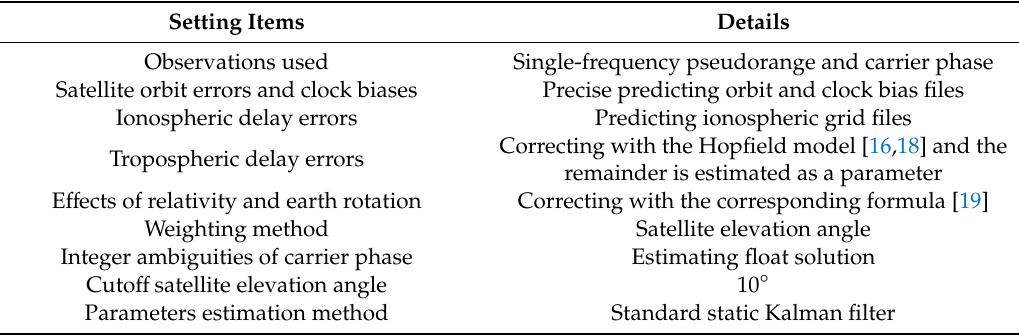
Table 1. The detailed settings of the precise point positioning (PPP) method used.